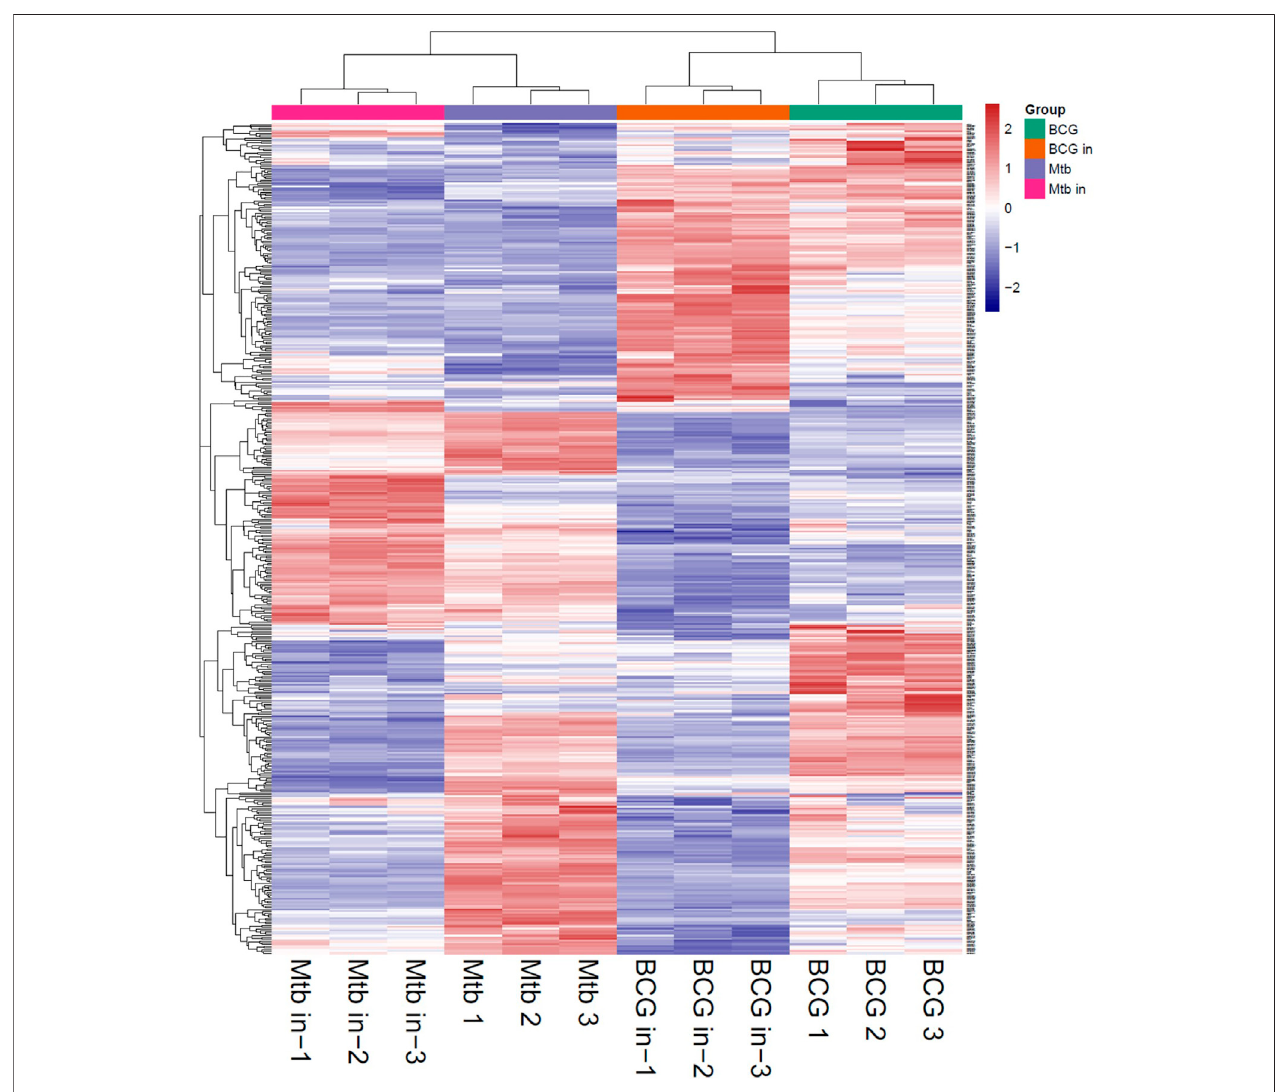
FIGURE 3 | Heatmap of all groups ( M.tb , intracellular M.tb , BCG, and intracellular BCG). Heatmap of proteins differentially expressed in all groups. Blue-to-red scale indicates low-to-high proteins expression levels. Differentially expressed proteins were de fi ned based on a threshold fold change > 1.5, at p < 0.05.